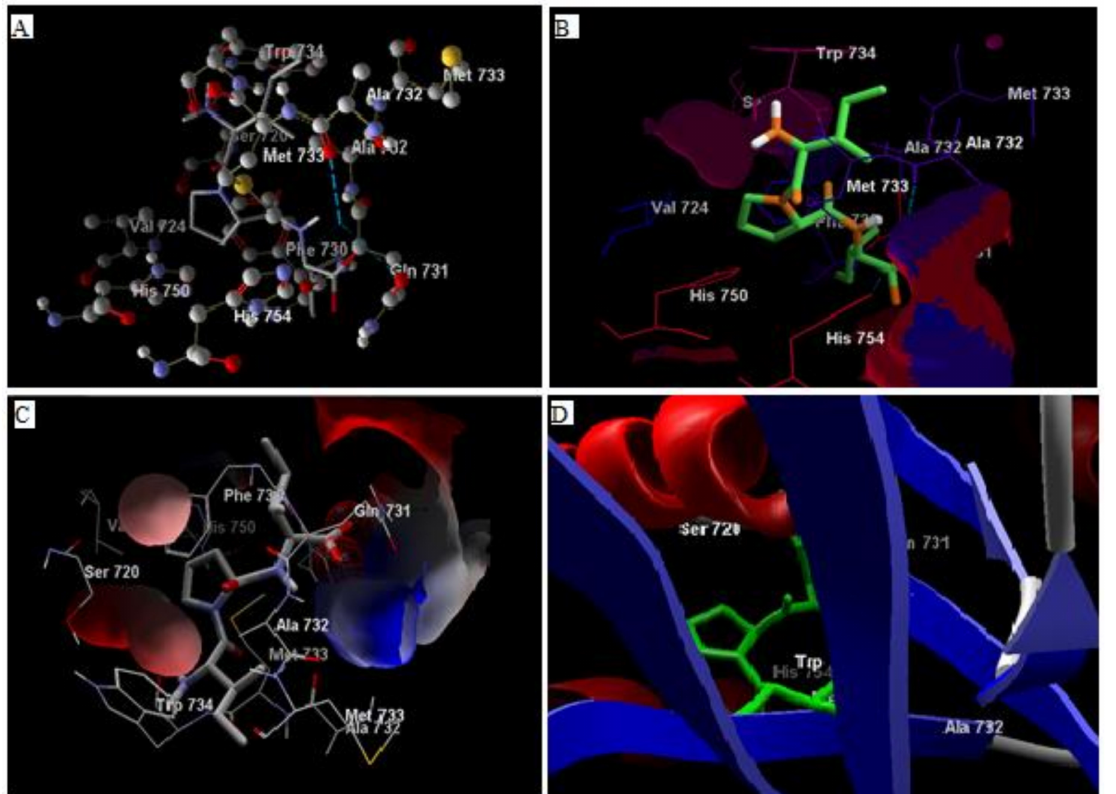
Figure 1. The hydrogen bonding ( A ), hydrophobic binding ( B ), electrostatic binding ( C ), and secondary protein interaction ( D ) of diprotin-A and dipeptidyl peptidase-IV